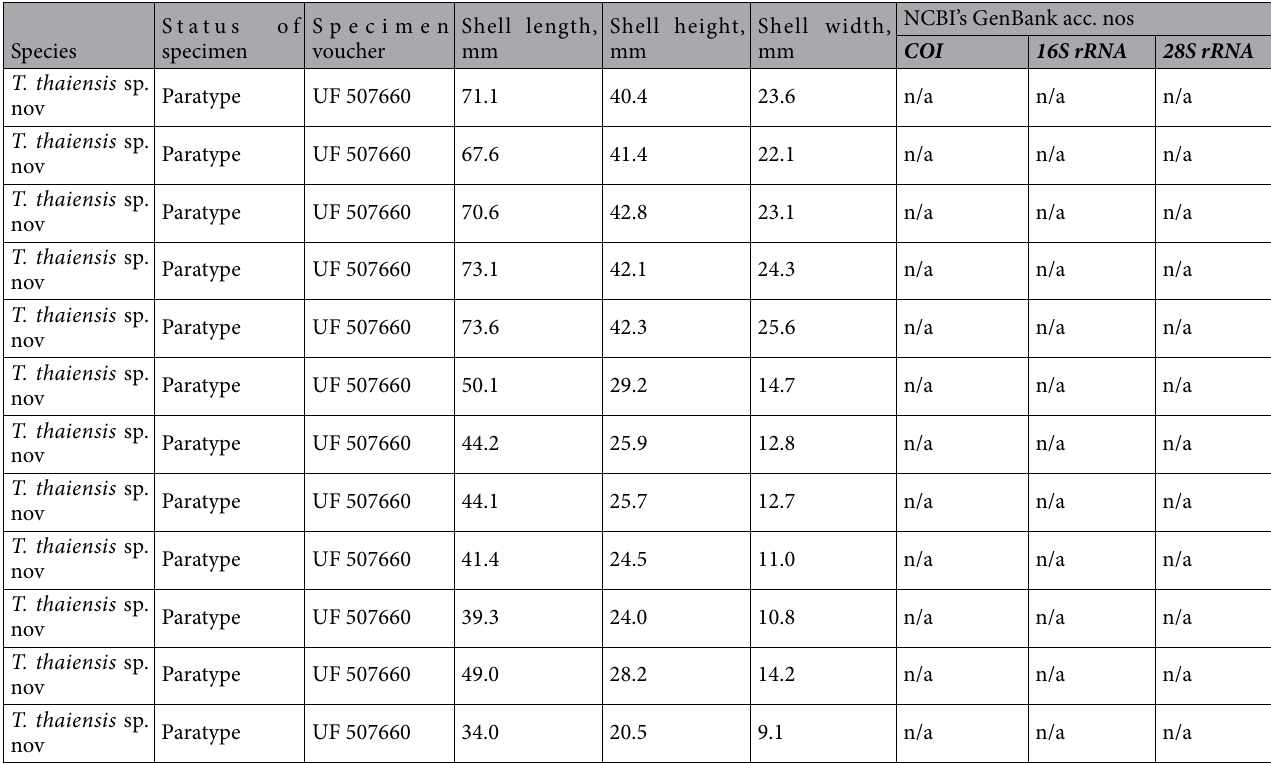
Table 3. Shell measurements and reference DNA sequences for the type series of new Bineurus and Thaiconcha species from